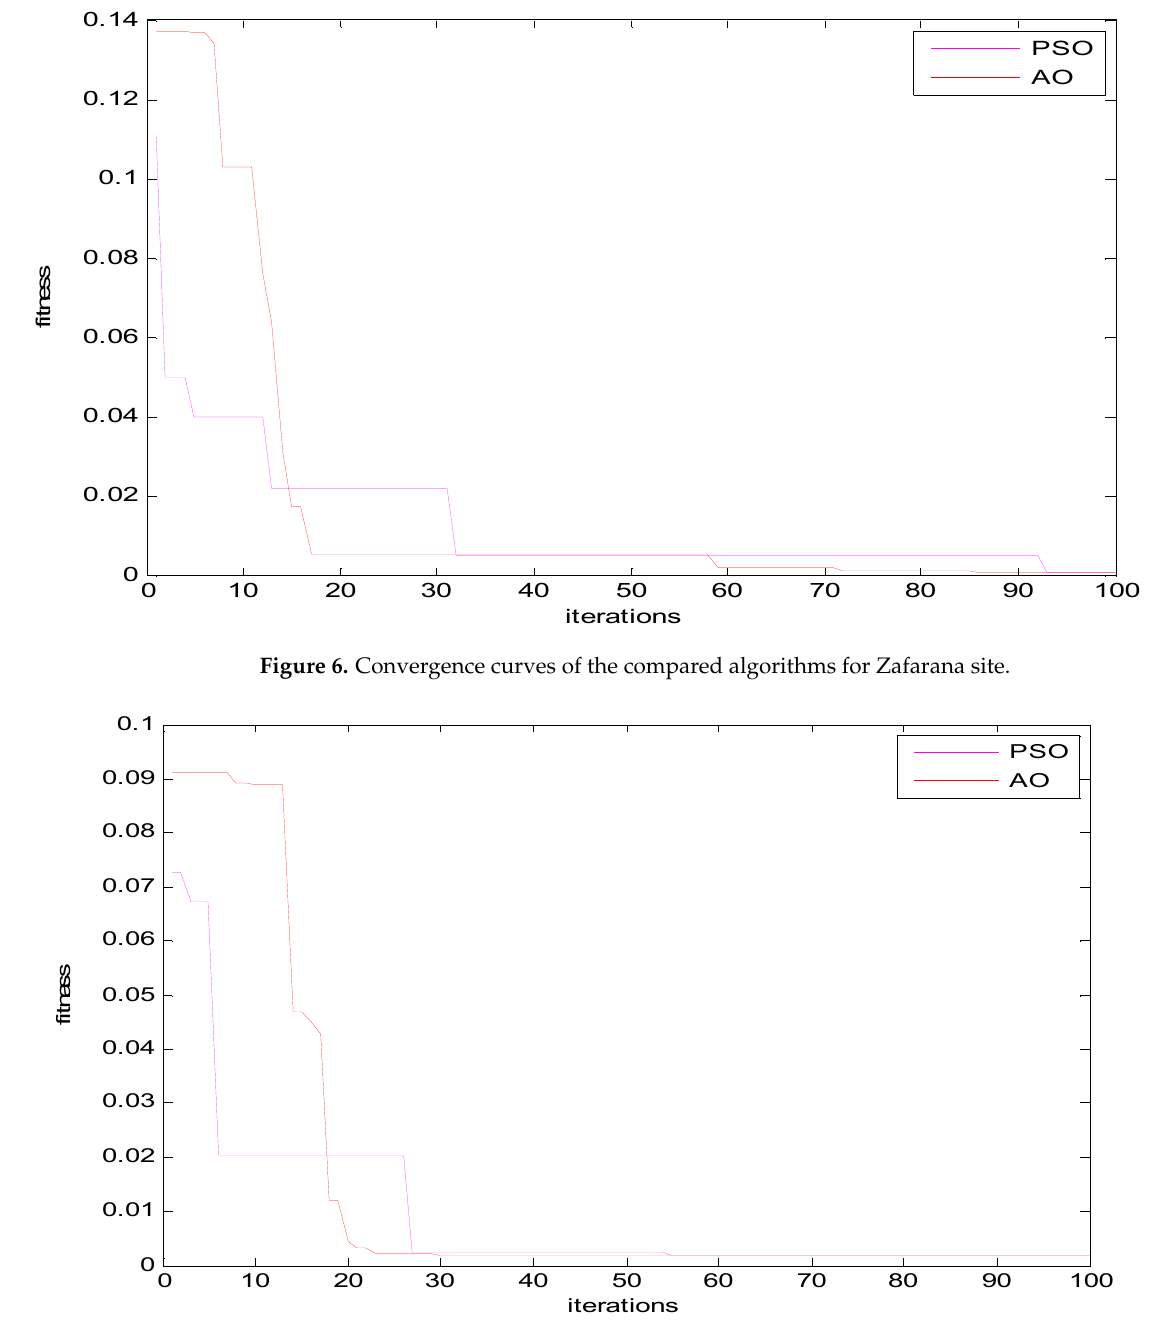
Figure 7. Convergence curves of the compared algorithms for Shark El-Ouinate site.